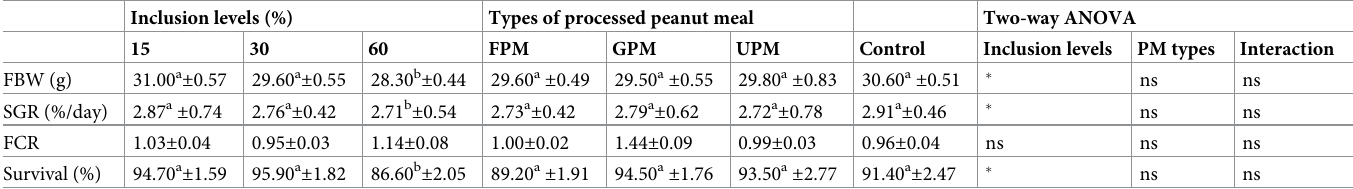
Table 4. Growth performances of juvenile barramundi at different inclusion levels and types of PM. Inclusion levels (%) Types of processed peanut meal Two-way ANOVA UPM Control Inclusion levels PM types Interaction FBW (g) ns ns SGR (%/day) 2.87 a ± 0.74 ns ns ns Within rows, values followed by the same letter are not significantly different (Bonferroni test). Two-way ANOVA being set significance at P < 0.05). FBW, final body weight; SGR, specific growth rate; FCR, feed conversion ratio; UPM, untreated peanut meal, FPM, fermented peanut meal; GPM, germinated peanut